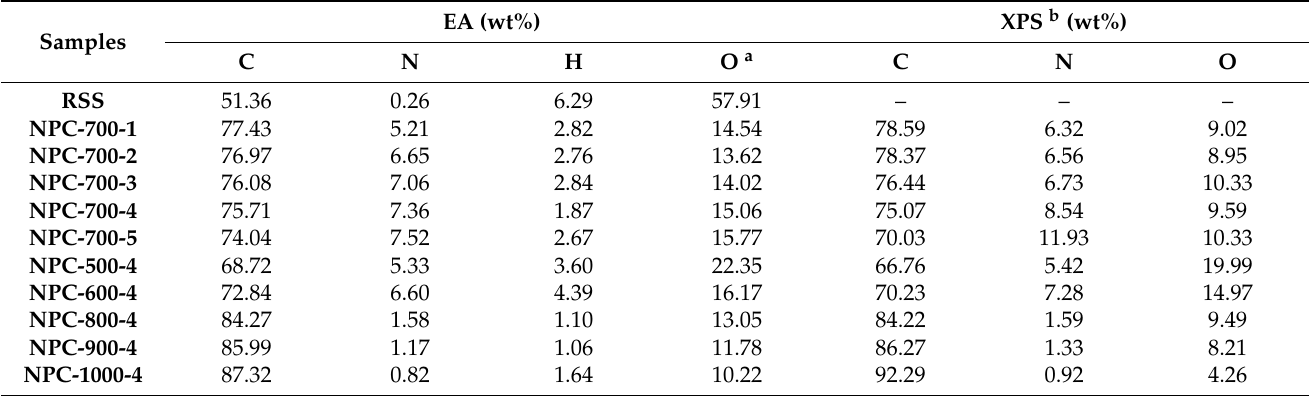
Table 1. Elemental analysis data for RSS and NPCs.